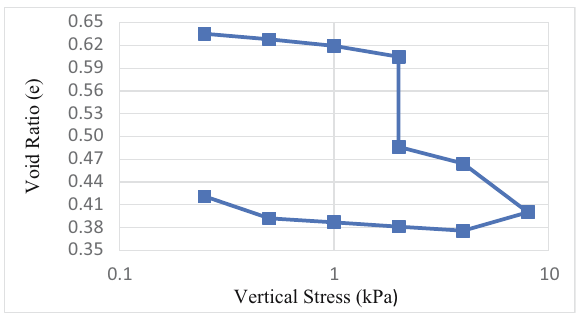
Figure 2: Single collapse test results on the natural soil.